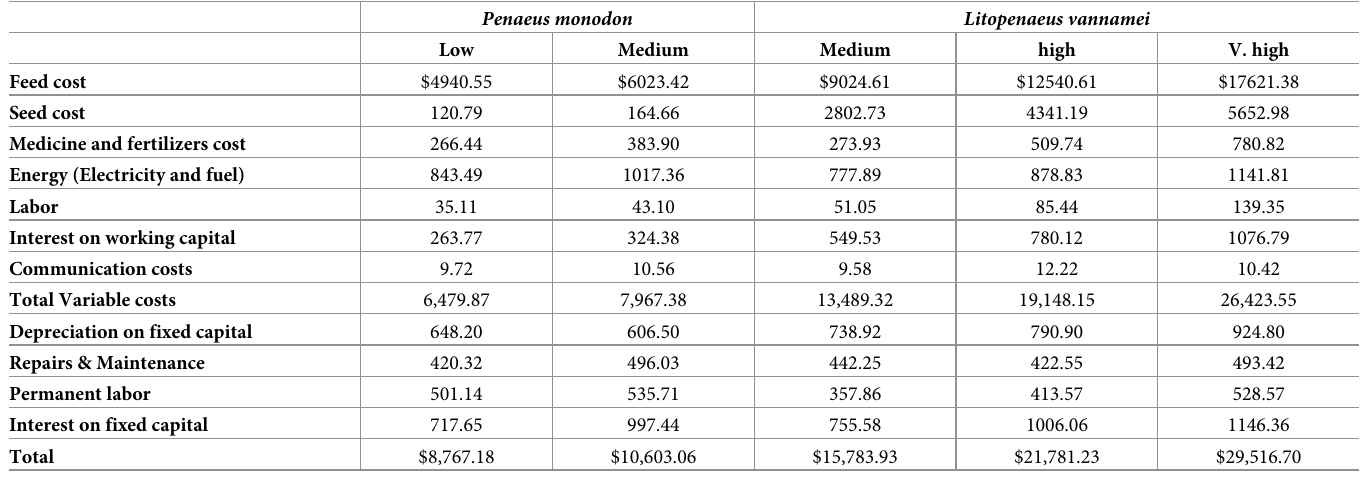
Table 4. Estimated cost of cultivation/ha in shrimp culture